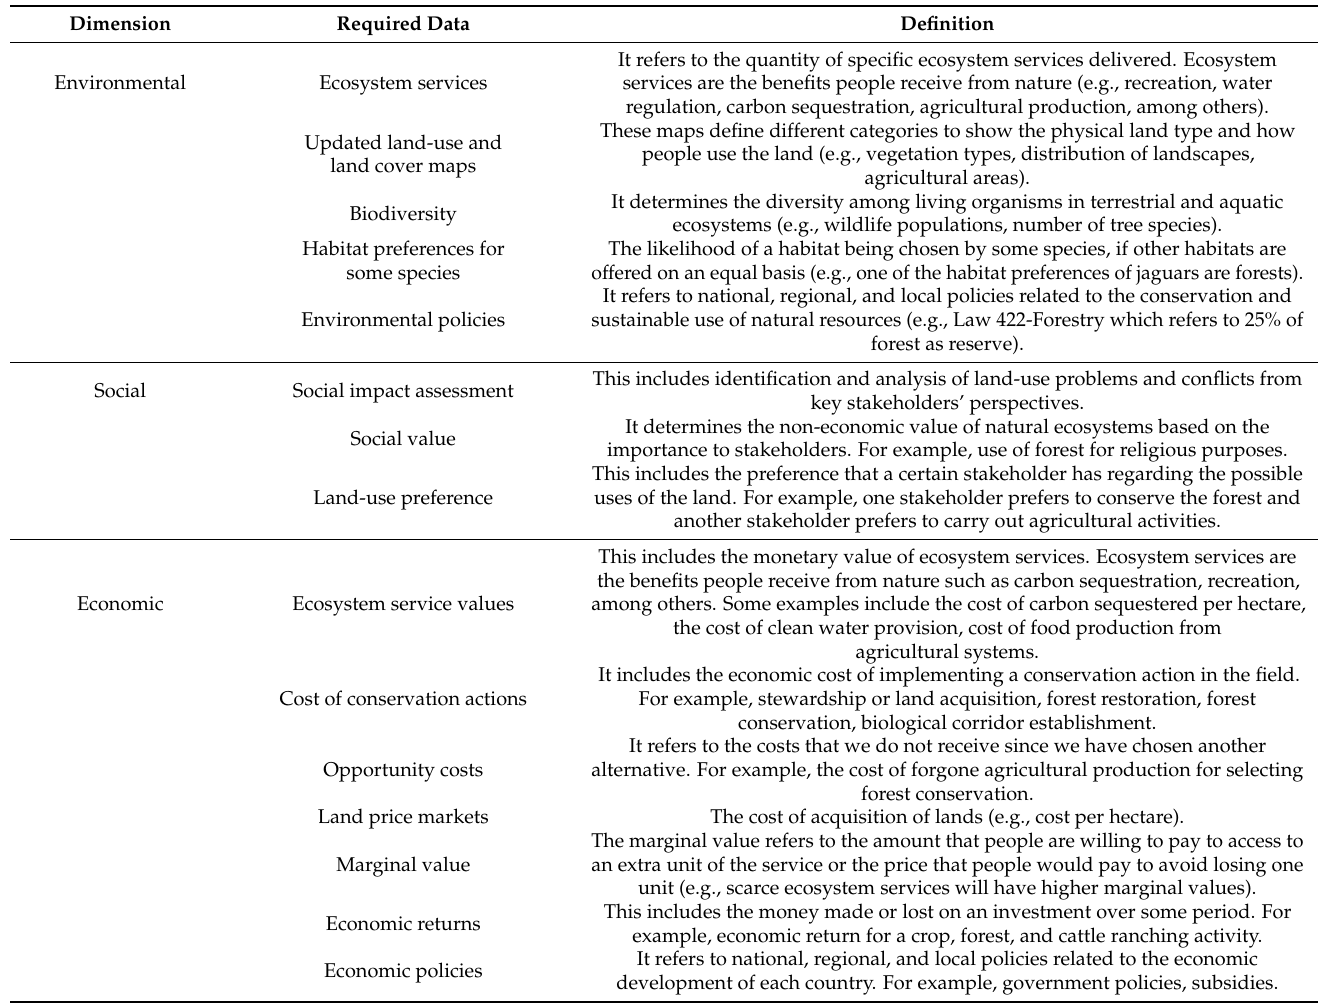
Table 2. Definitions provided for each data needs in the